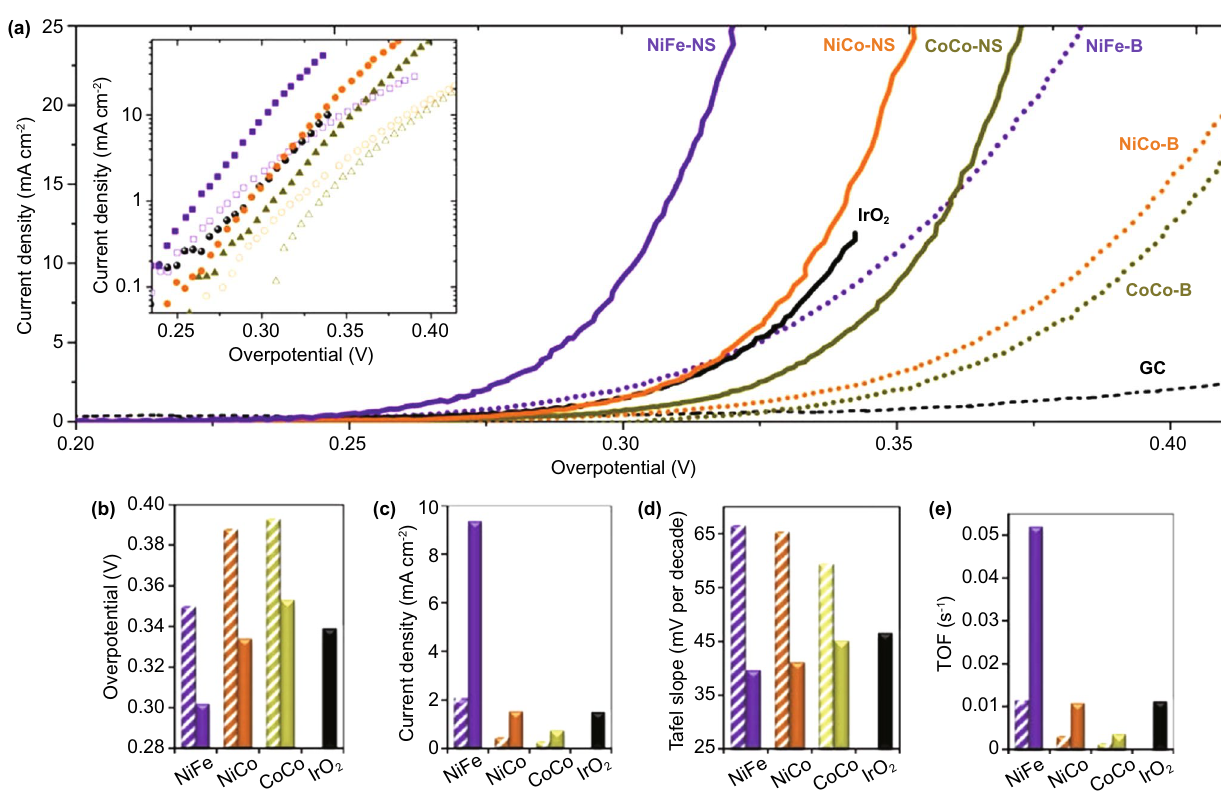
Fig. 9 Layered double hydroxide (LDH) nanosheets for catalytic oxygen evolution reaction (OER) enhancement. Reproduced with permission [345]. Copyright 2014, Springer